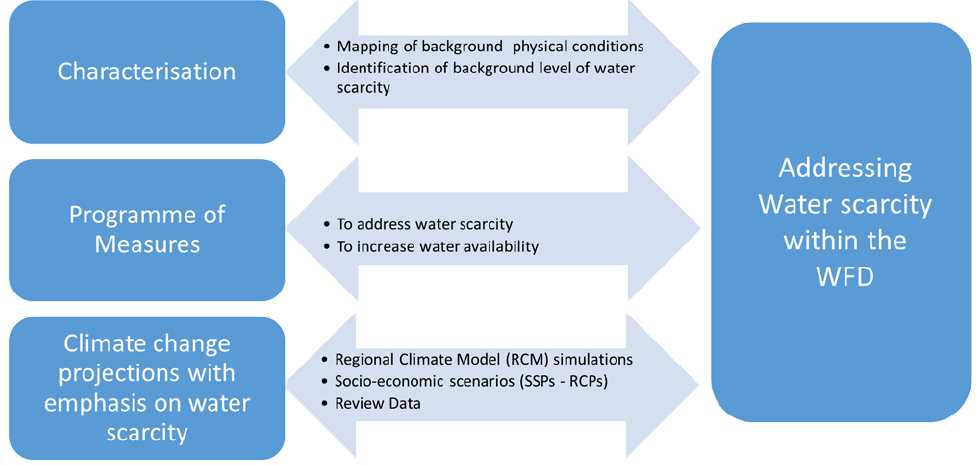
Figure 1. Schematization of the process followed in Globaqua. WFD: Water Framework Directive.